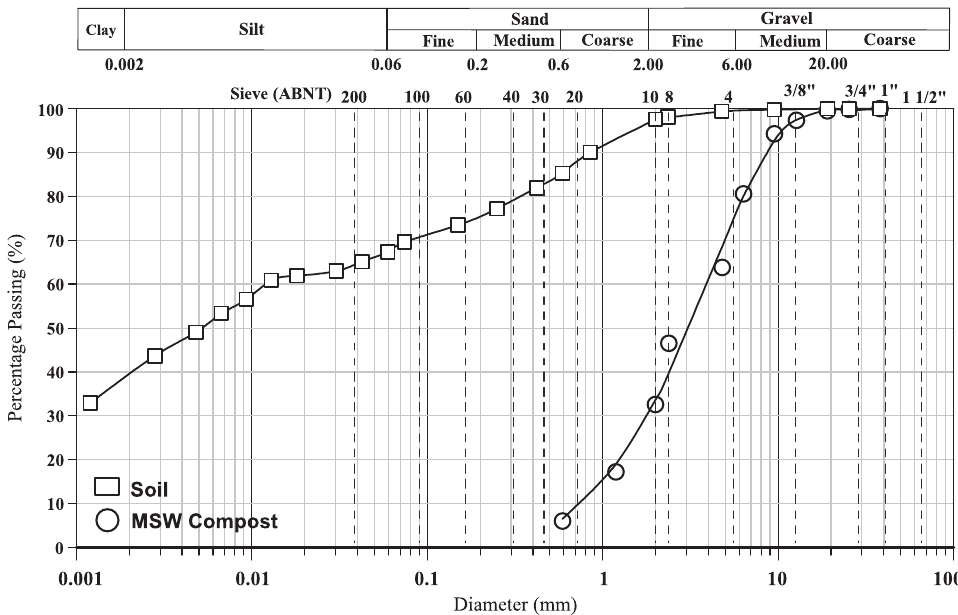
figure 2. Granulometric analysis of msW compost and soil.